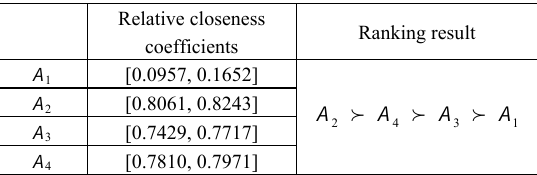
Table 4. Ranking result of strategic R&D projects